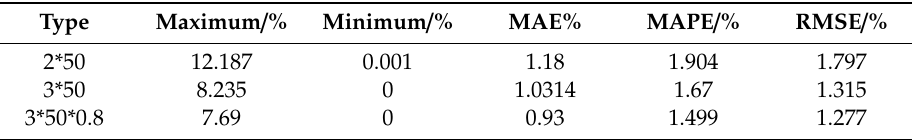
Figure 13. Filling result curves of different inputs (air humidity (AH), photosynthetically active radiation (PAR), soil temperature (ST), AH + PAR, AH + ST, PAR + ST, AH + PAR + ST). Table 11. Comparison of error statistical